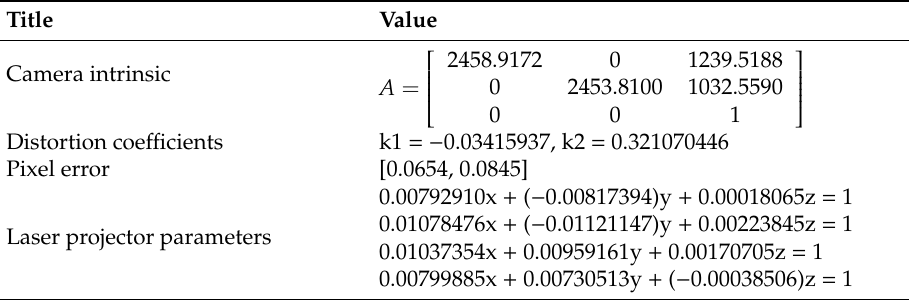
Table 2. Calibration parameters of the structured optical system.